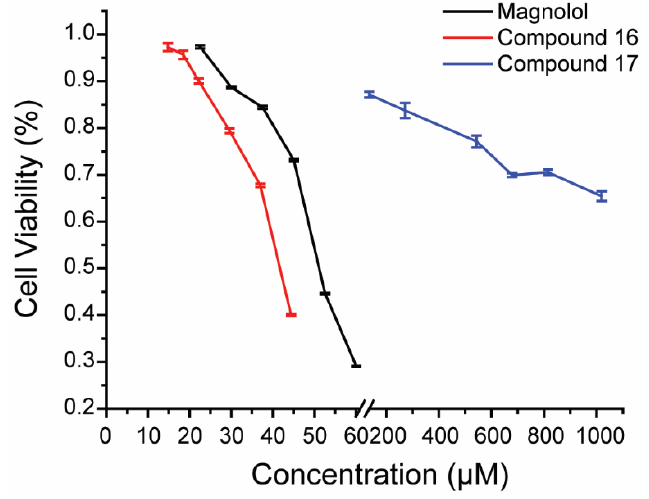
Figure 3. Cytotoxicity of magnolol, compound 16, and compound 17 toward GCO cells. Data are presented as the mean ± SD. Table 2. The 20% cytotoxic concentration (CC 20 ) of three compounds toward GCO cells ( ± 95% confidence interval) and their inhibitory rate of MSRV proliferation at CC 20 .